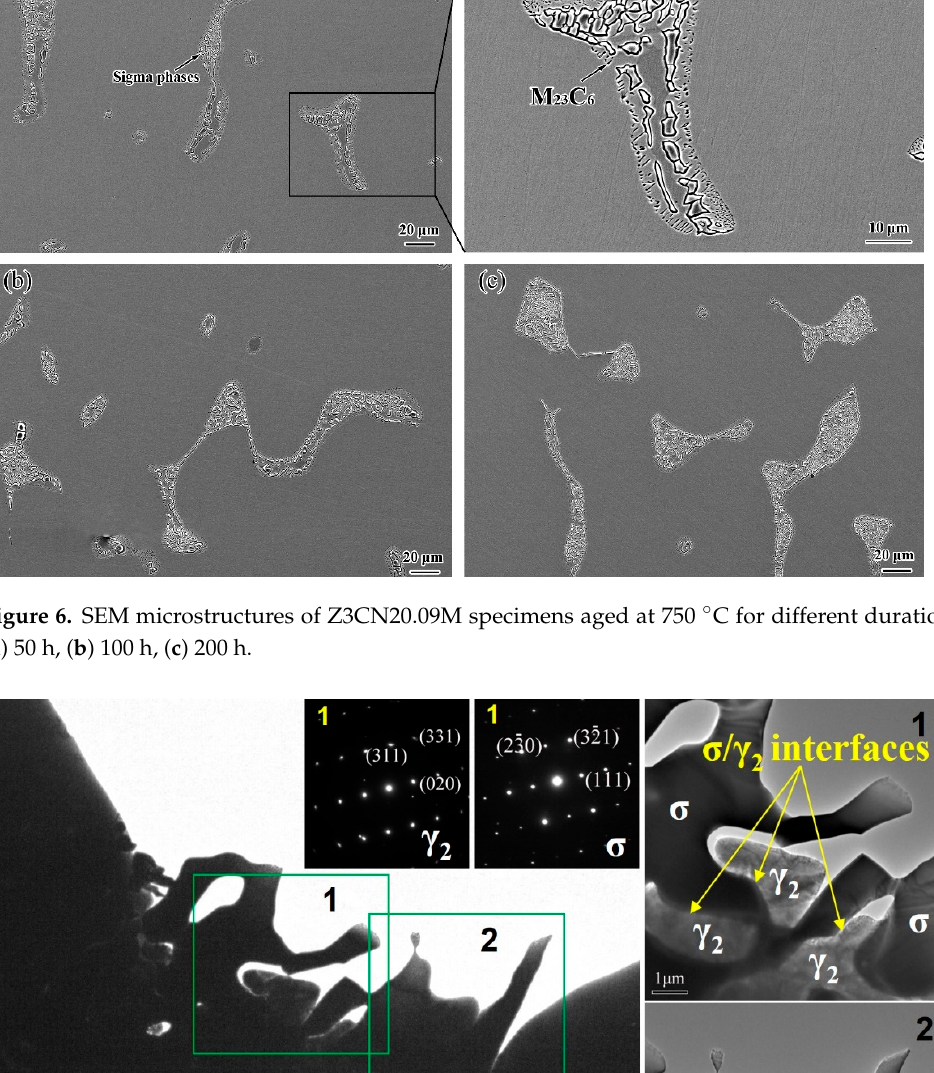
Figure 8. Variation in sigma content in Z3CN20.09M CASS specimens aged at 750 °C with aging times.